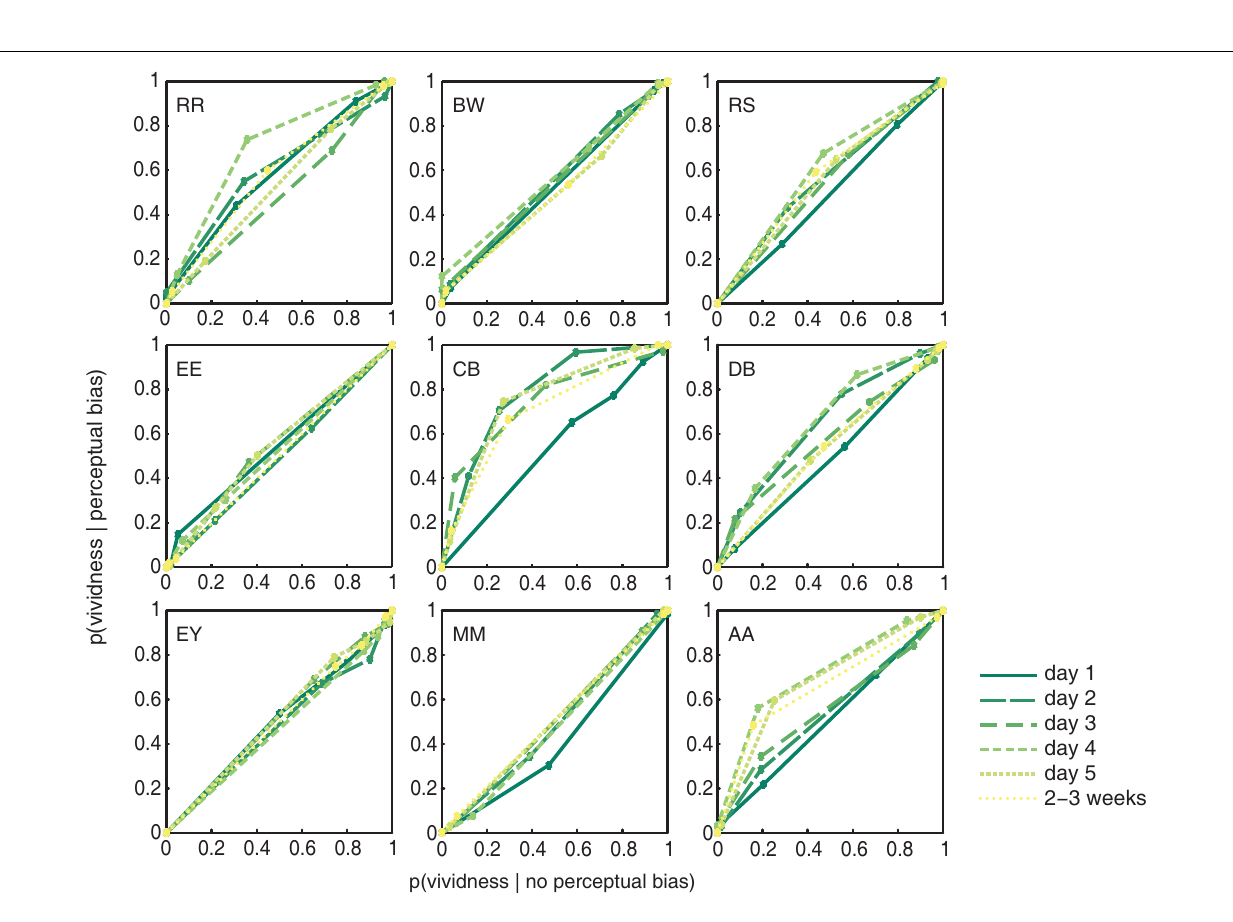
FIGURE 4 | Participant’s metacognition of imagery over the course of training. ROC II curves based on the vividness ratings reported by our participants (collapsed over Gabor orientations). Each plot represents an individual participant; the colored lines represent the ROC curves for the different days of